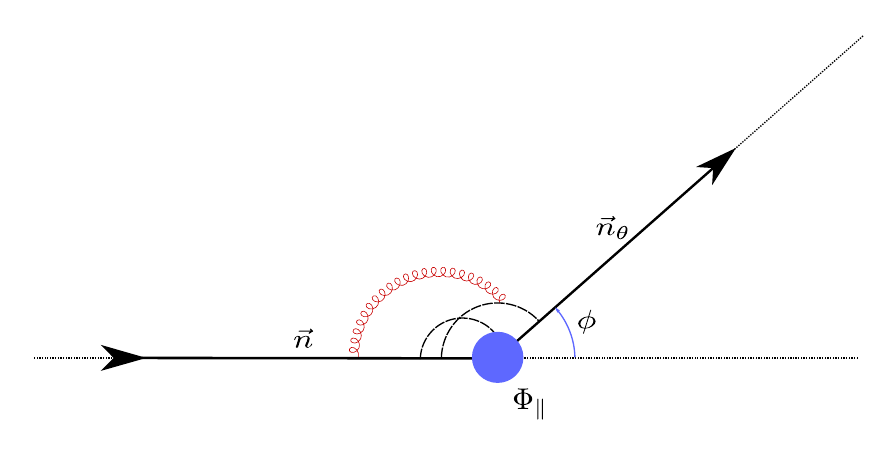
Figure 1 . The excited cusp: a Feynman diagram for the insertion of (cid:8) (denoted by the blue dot) at k the cusp of two semi-in(cid:12)nite Wilson rays, forming a cusp with angle (cid:30) . The angle between the scalars coupled to the two rays is (cid:18) . Dashed lines represent scalar propagators, whereas gluon propagators are depicted by the usual spiral. In contrast to the insertions considered in [23, 24, 29], the scalar insertion in this case can interact with the scalars that couple to the Wilson line. Therefore, in addition to having the gluon-scalar-scalar vertex, we are also allowed to have a scalar propagator that goes from the insertion to the